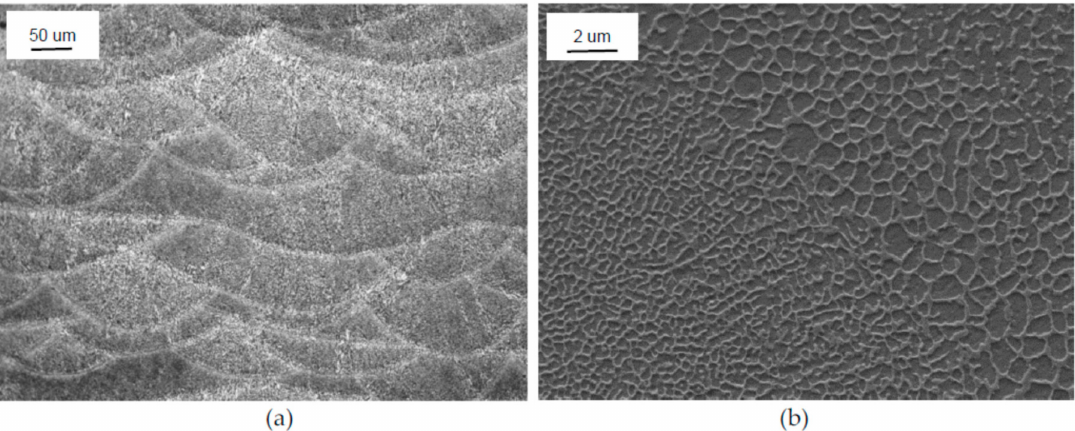
Figure 1. Microstructure of the AlSi10Mg alloy produced by selective laser melting (SLM) on a cold platform. ( a ) Low magnification optical microscope view (section plan parallel to building direction) of the solidified melt pools left by laser tracks; ( b ) SEM image of the cellular structure.